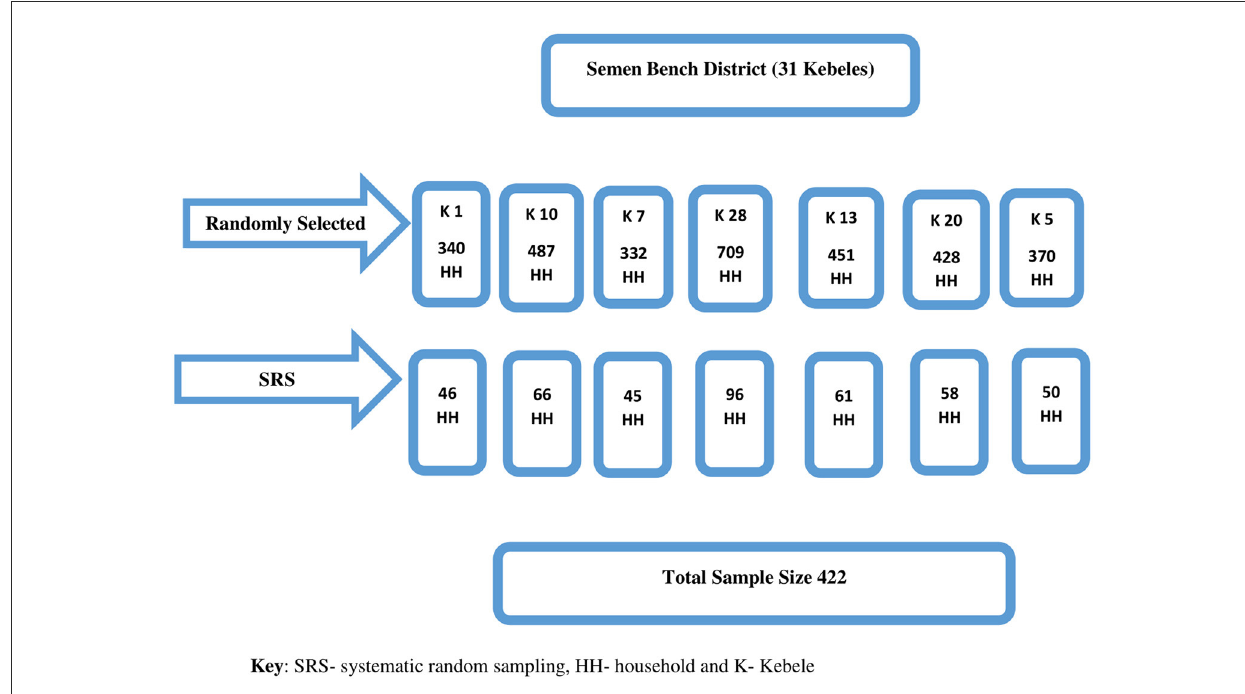
FIGURE1 Schematic presentation of the sampling procedure to assess cultural malpractice during the perinatal period in southwest Ethiopia.